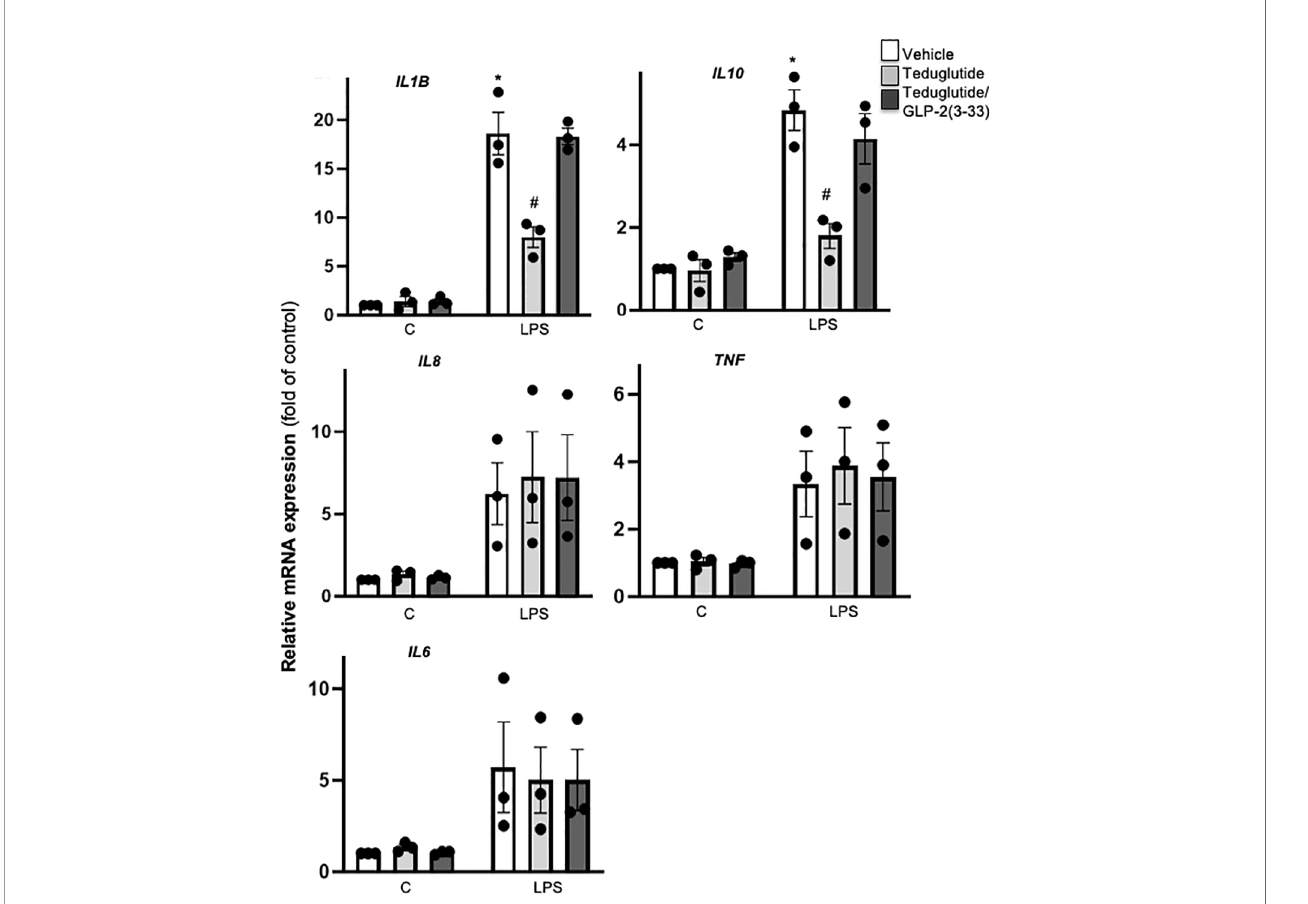
FIGURE 4 | Intra-islet GLR-2R activation dampened LPS-induced islet in fl ammation. Isolated human islets were cultured on ECM-coated dishes and treated with 10 nM teduglutide or 10 nM teduglutide plus 5 nM GLP-2(3-33) for 2 hours, then LPS was added to the culture medium for 24h. Total RNA was isolated and cytokine and chemokine expression analyzed by realtime RT-PCR. Data are shown as means ± SEM from n = 3 different human islet isolations. *p < 0.05 vs . control, # p < 0.05 teduglutide vs . vehicle control by 2-way ANOVA with Sidak ’ s